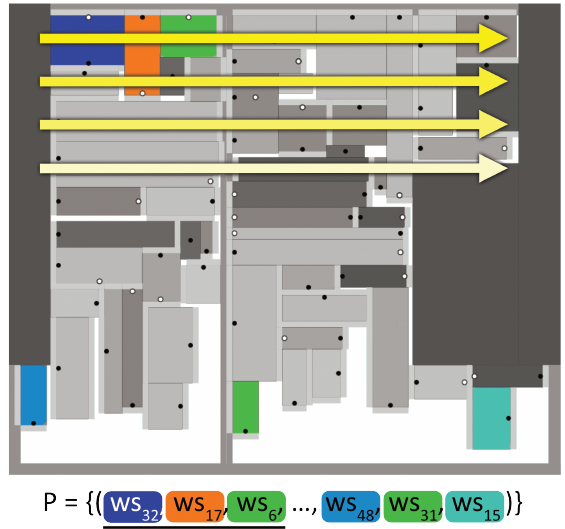
Figure 2. Illustration of the effect of mapping of the priority list P to the floor plan. Each term ws i stands for a tuple representing a particular variant of the workstation i . Workstations are placed into the floor plan in a top-down manner as indicated by the yellow arrows of decreasing intensity. The head part of the priority list ( ws 32 , ws 17 , and ws 6 ) maps to the top region of the floor plan. The tail part of the priority list ( ws 48 , ws 31 , and ws 15 ) maps to the bottom region of the floor